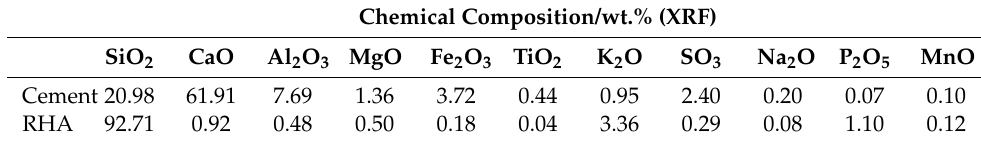
Table 1. Chemical compositions of cement and RHA. Chemical Composition/wt.%